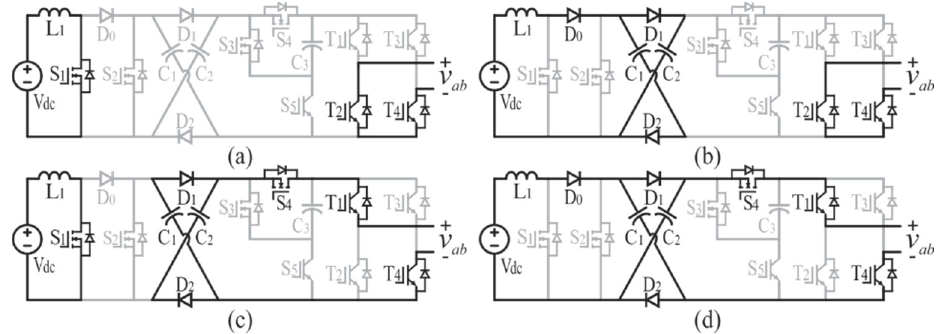
Figure 3. Operation states in the positive output voltage period of the proposed NLBI. ( a ) State 1, ( b ) State 2, ( c ) State 3 and ( d ) State 4.